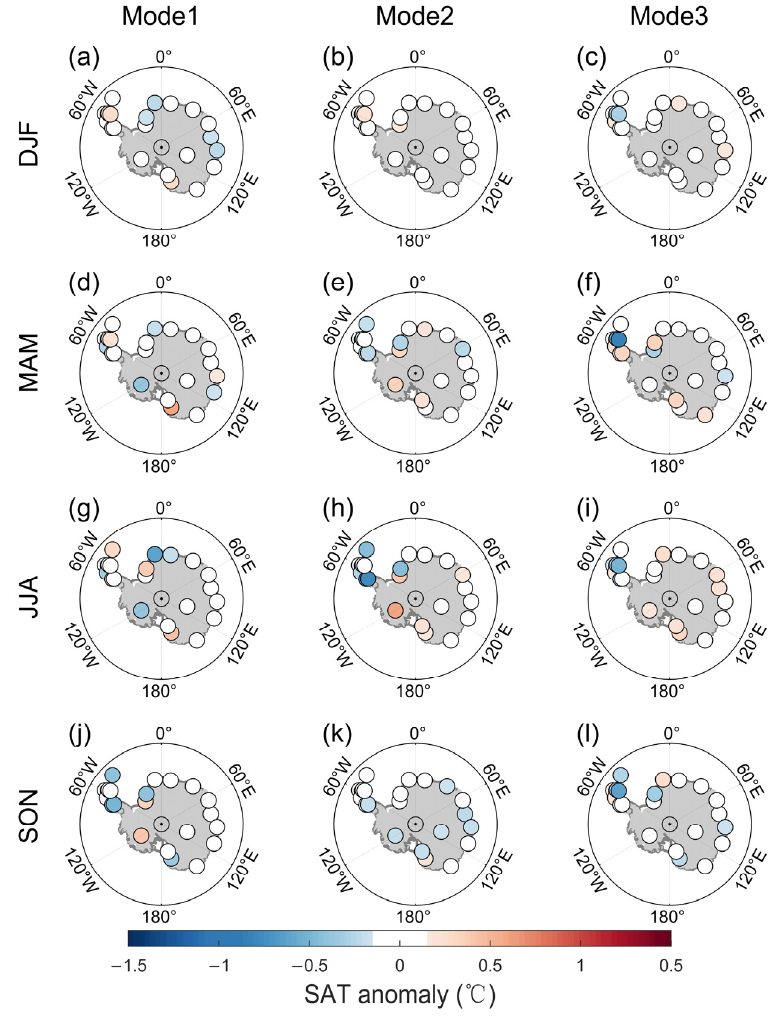
Figure 8. Same as Figure 7, but for the difference between the ensemble mean of reanalyses and observations.